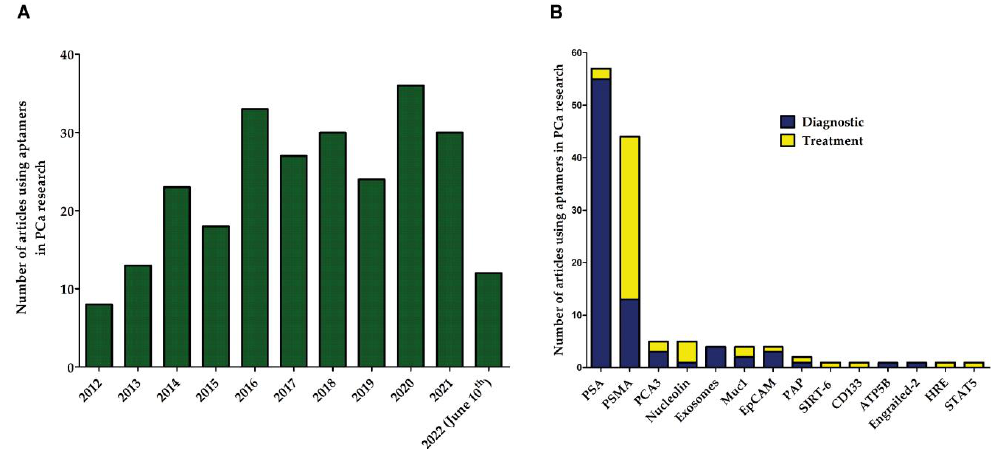
Figure 4. Aptamer publications in PCa research. ( A ) Yearly trend of published articles reporting the use of aptamers in PCa. ( B ) Proteins used as targets of the aptamers in PCa research. Blue bars represent the number of articles using aptamers directed against each protein in diagnosis, whereas yellow bars refer to articles using aptamers in PCa therapy. PCA3 = prostate-cancer-associated 3; Muc1 = mucin 1; EpCAM = epithelial cellular adhesion molecule; PAP = prostatic acid phosphatase; SIRT-6 = sirtuin 6; CD133 = prominin-1; ATP5B = ATP synthase F1 subunit beta; HRE = hormone response element; STAT5 = signal transducer and activator of transcription 5A.